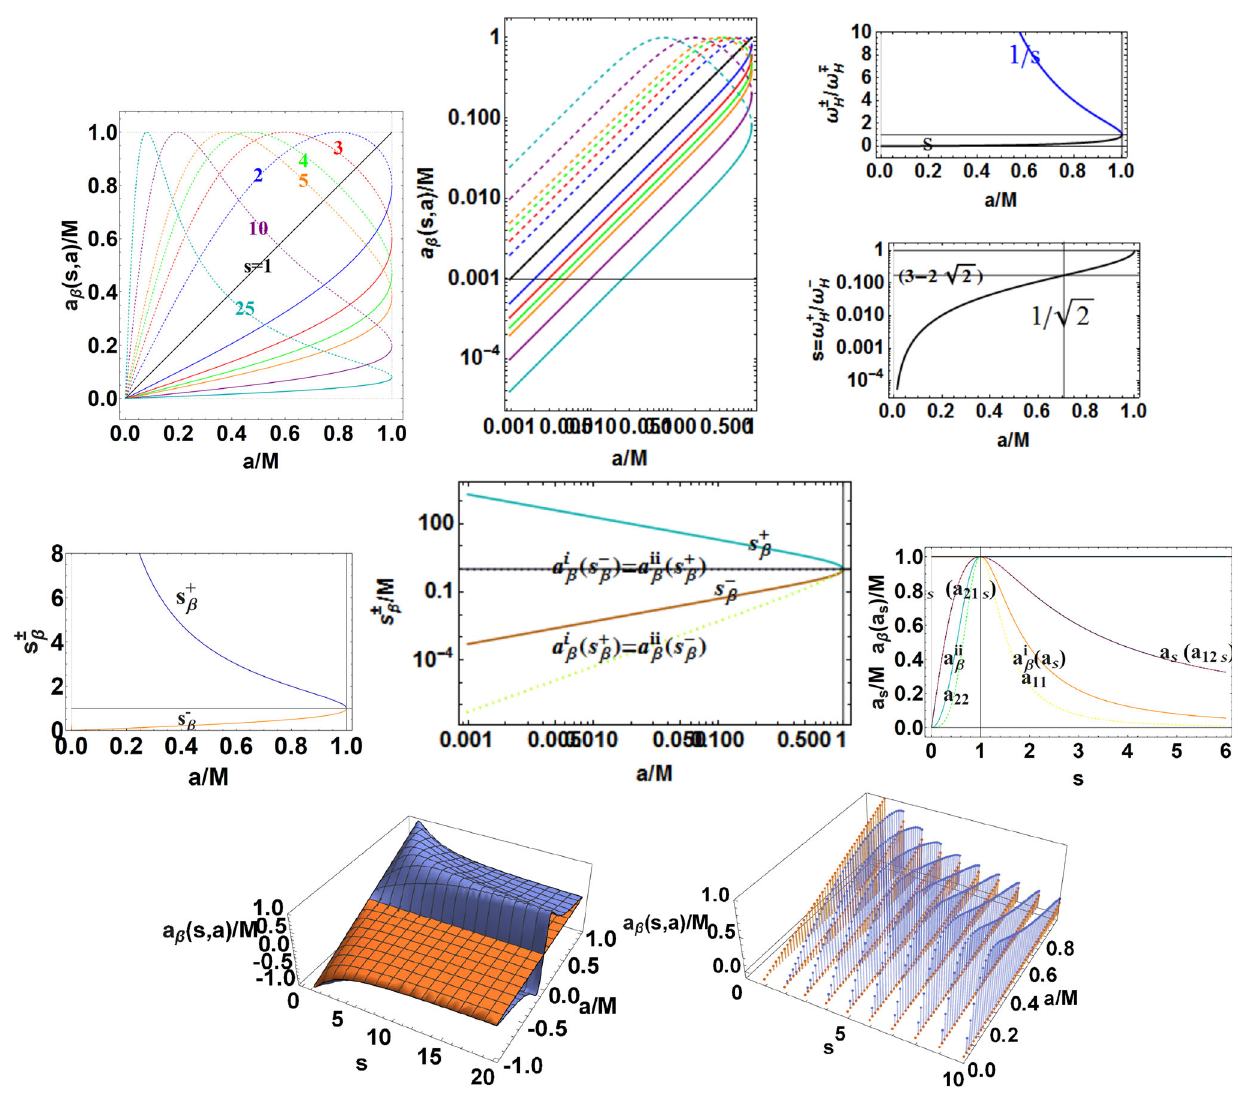
√ Fig. 26 Upper line. Left panel: spins a β = { a i β , a ii β } of Eq. (77) for 2. Here s = 1 for a g = M . Center panel line. saddle point a ∂ = M / /ω − Left: ratios s ± β of Eq. (81) as functions of the tangent spin a g / M and as functions of the tangent different resonance solutions s ≡ ω + H H maximum of a β = ( a i β , a ii β ) with respect to s . The role of s = 1 for spin a of the second frequency bundle ω ± , in accordance with Eq. (77). H The identity for s = 1 and the symmetry for s → 1 / s are shown. Note a = M and the symmetries of ( s + β , 1 / s − β ) are explicitly shown. Cen- the behavior as s increases. Plots provide also the classes of metric ter panel: di-logarithmic plot of s ± β and the functions ( a i β , a ii β ) on s ± β . bundles with same resonant frequencies. The situation for a fixed BH Right panel: maximum spin a ∫ ( s ) of Eq. (79) as function of s . The geometry with spin a g is described by vertical a g = constant line of spins maximum a β ( a ∫ ) , Eq. (79), and a 11 = a i β ( a i β ) , a 22 = a ii β ( a ii β ) , the graph (which is clearly independent of the plane σ ). Central panel: a 12 = a i β ( a ii β ) , a 21 = a ii β ( a i β ) are also shown, where a 12 ∪ a 21 = a ∫ . logarithmic plot shows the logarithmic identities discussed in the text Bottom panel lines: 3D plots of a ± β as functions of a g ∈ [− M , M ] and (generally in the form ln Q 1 ( ln q 1 ) = − ln Q 2 ( ln q 2 ) for any quantities { Q , Q , q , q } ). Right panel: s ( a ) as function of the bundle tangent s (left panel) for s ∈ N (right g 1 2 1 2 spin – Eq. (75). Note the relation between ( s , s − 1 ) and the role of the